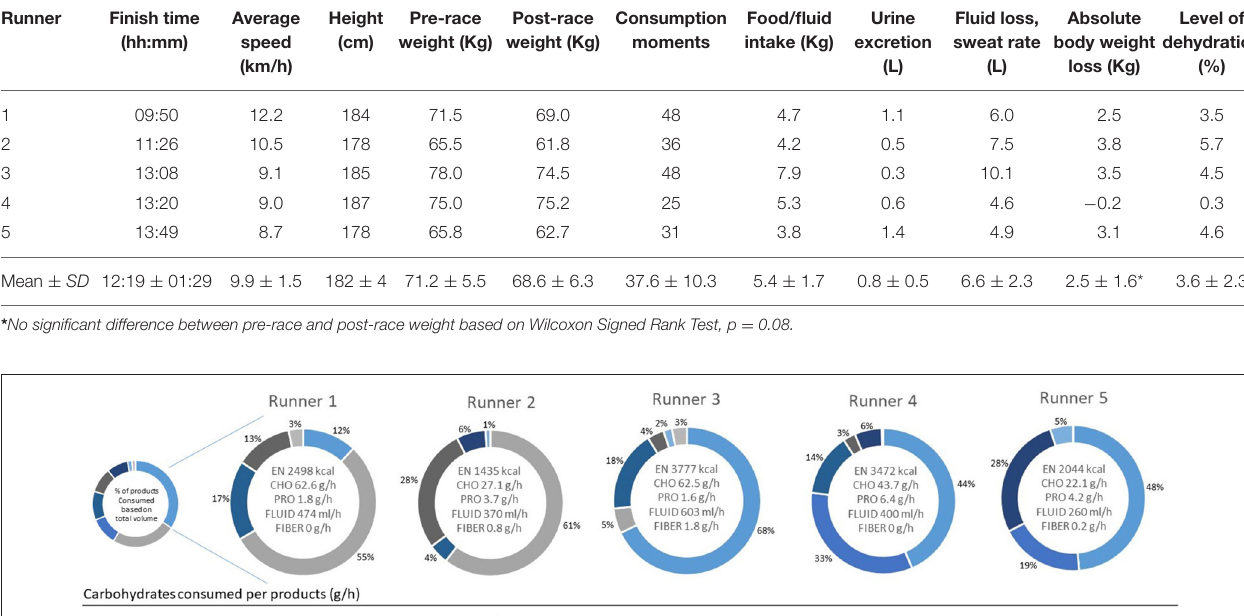
TABLE 1 | Characteristics of ultramarathon runners during 120km race ( n = 5). Runner Finish time (hh:mm)